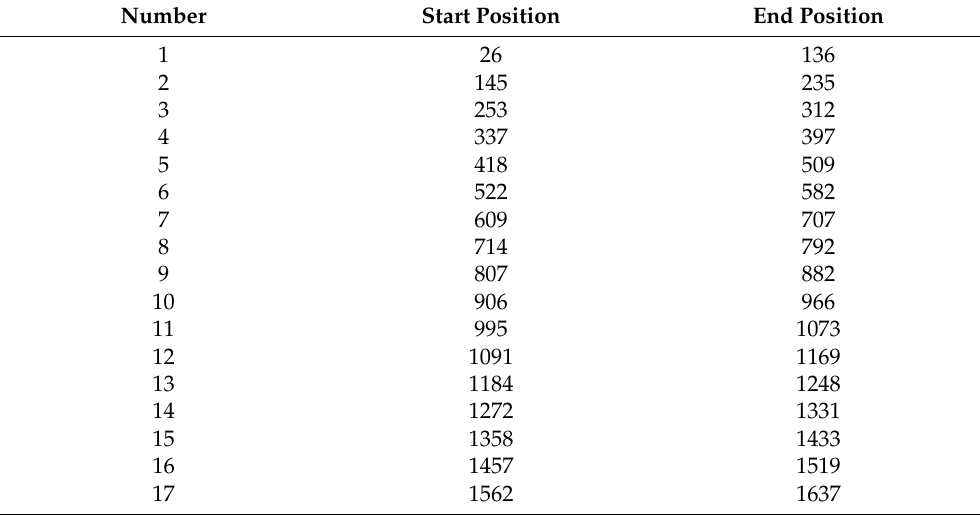
Table 1. The extracellular domains of porcine Sn protein.